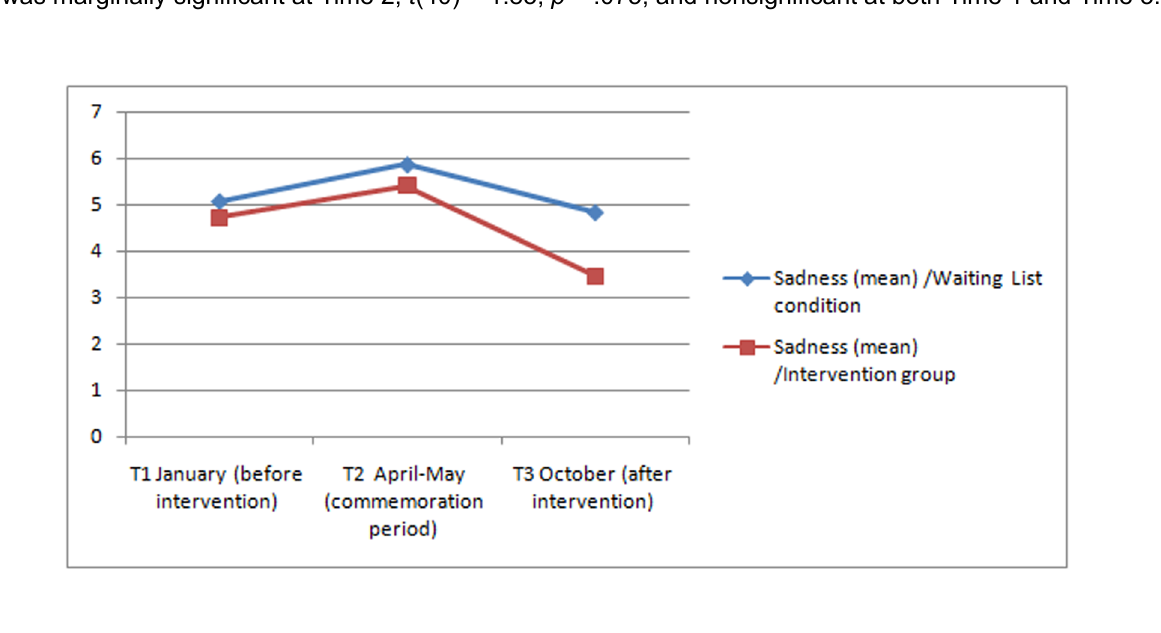
Effect of Group Intervention on PTSD and Depression Symptoms, Loneliness and Resilience Scores Mixed-between group ANOVAs were also computed on the measures of loneliness, depression, impact of events and resilience. Mauchly’s test indicated that the assumption of sphericity was met for loneliness, χ 2 (2) = 3.77, p = .15, depression, χ 2 (2) = 2.01, p = .36, and resilience, χ 2 (2) = 1.92, p = .38, but was violated for IES-R, χ 2 (2) = 63.81, p < .001. Degrees of freedom for IES-R were corrected using Greenhouse-Geisser estimates of sphericity (ε = .55). Corrected tests are displayed in Table